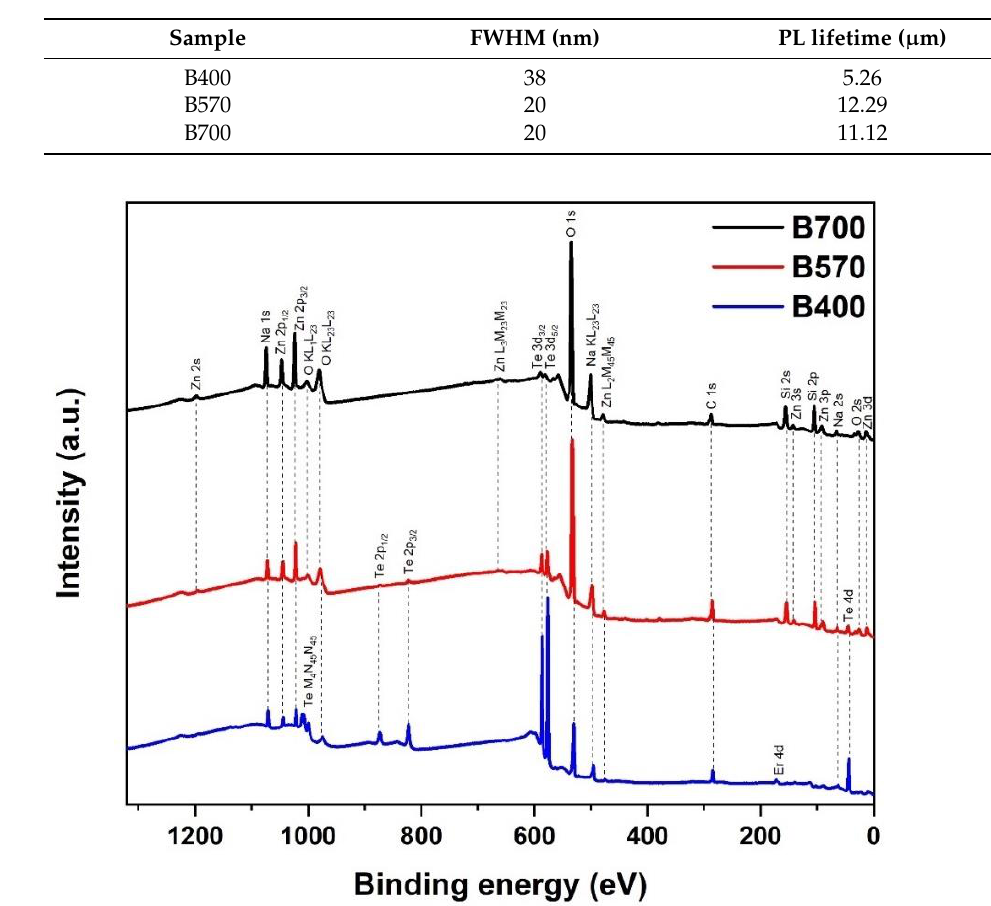
Figure 4. XPS survey scan for samples B400, B570 and B700.